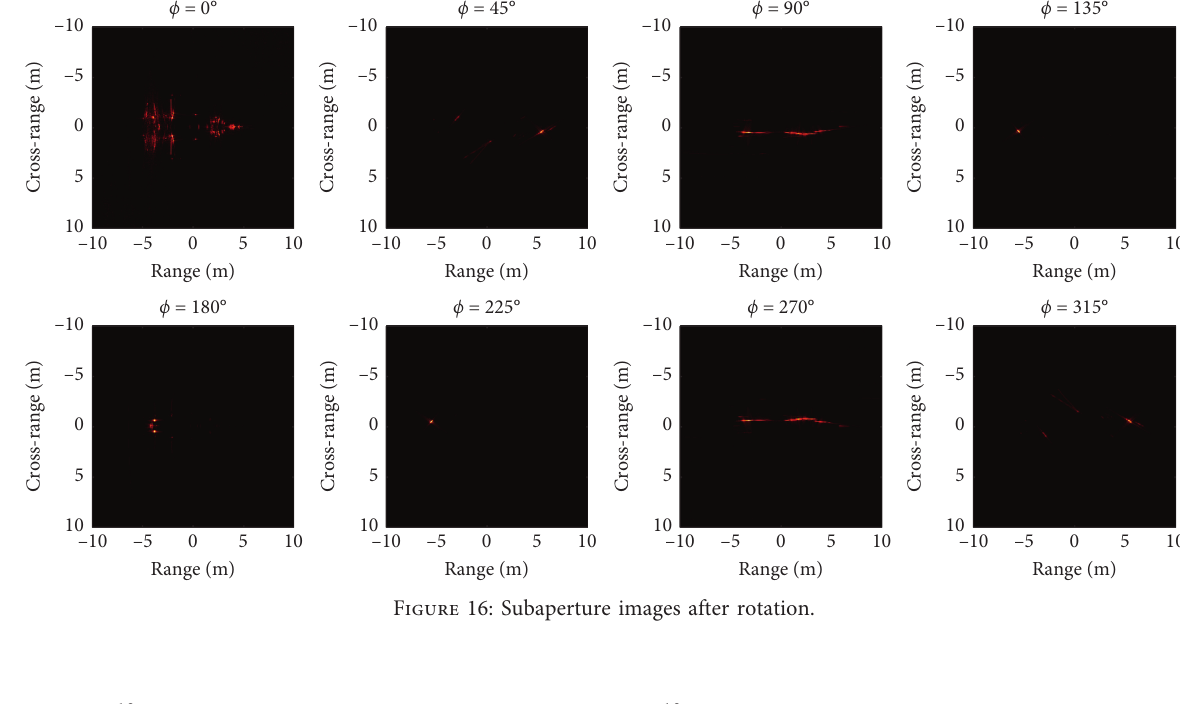
Figure 16: Subaperture images after rotation.